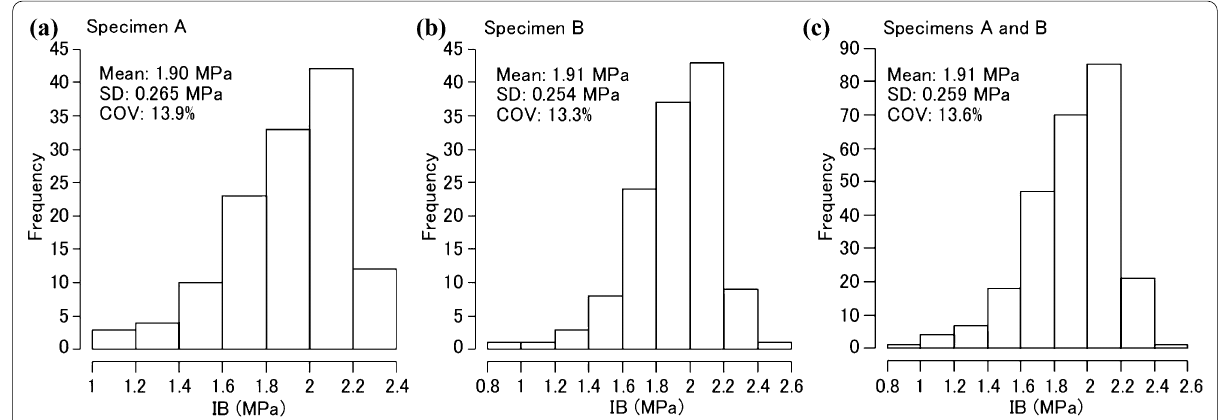
Fig. 3 a Histogram of 127 internal bond (IB) values of specimen A. b Histogram of 127 IB values of specimen B. c Histogram of 254 IB values of the adjacent specimens A and B. SD standard deviation, COV coefficient of